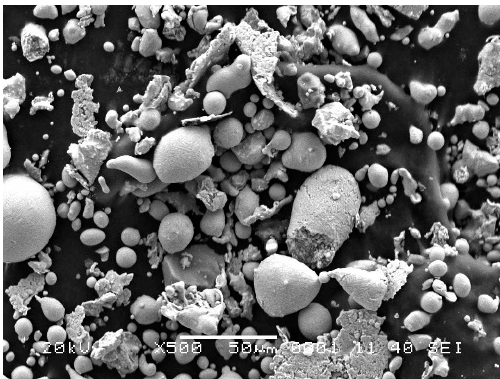
Figure 1. SEM morphologies of pre-alloyed powder.